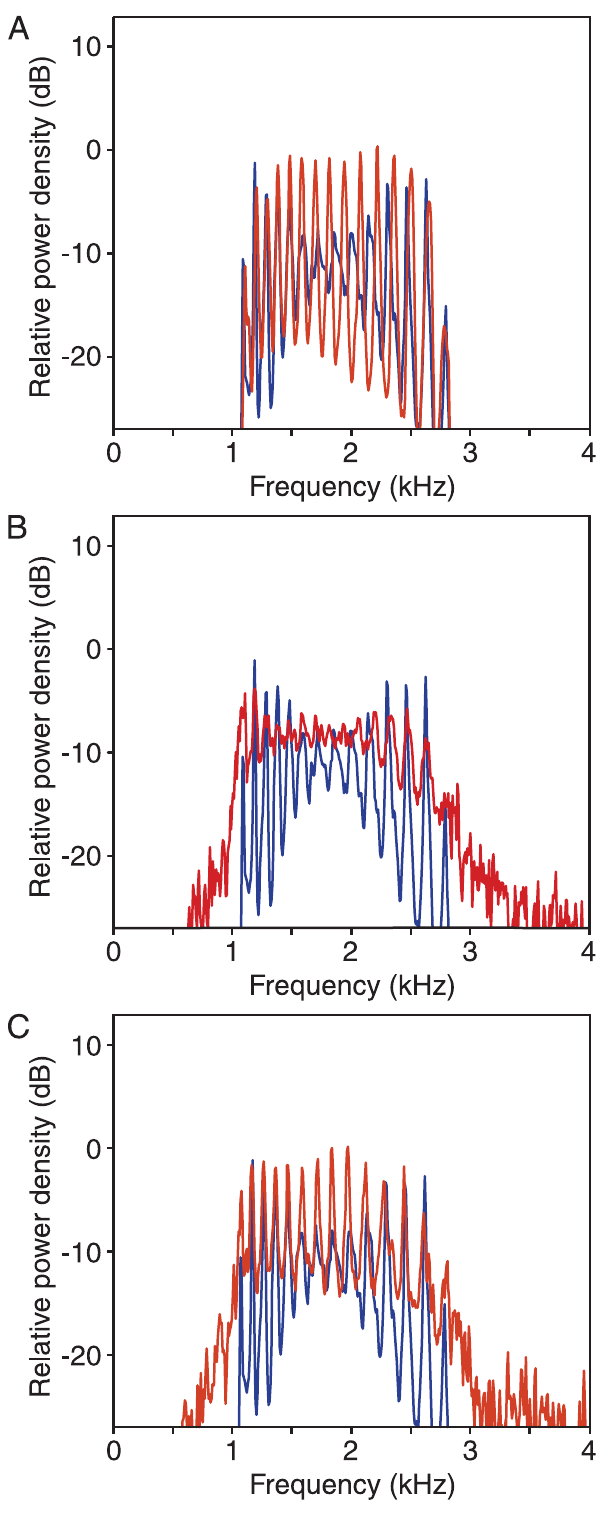
Figure 5. The effects of disorder and noise. A. When all the oscillators are identical, the central peaks of the power spectrum are poorly defined (blue trace). Introduction of random disorder in the value of the free-running amplitude a locks the oscillators into particular groups and thereby sharpens the power-spectral peaks (red trace). In this instance, the value of a over the central 74 oscillators follows a normal distribution with a mean of unity and a